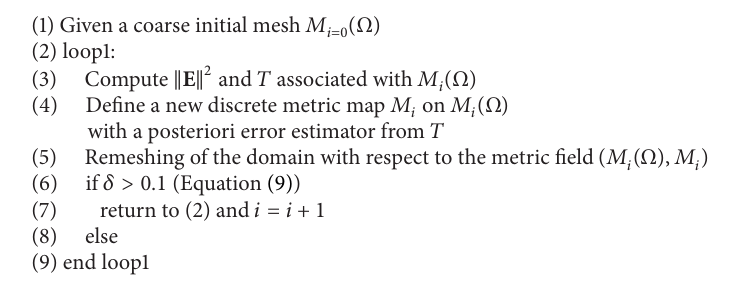
Algorithm 2: Algorithm of adaptive remeshing strategy 𝐴 2 .